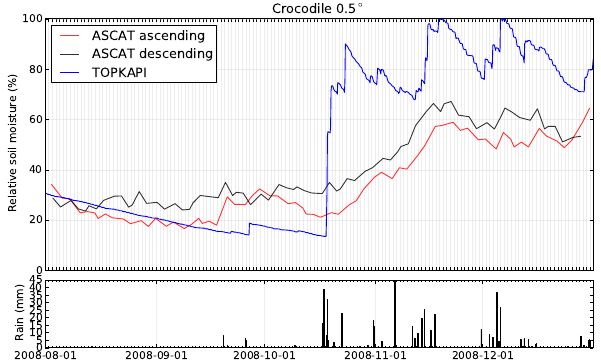
Fig. 15. Site D – Crocodile. The description of this figure is the same as Fig. 13, except that a 0.5 ◦ block has been